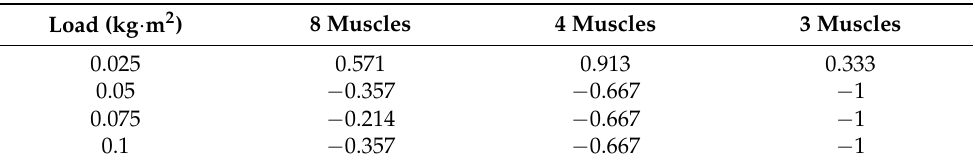
Eight muscles sequence corresponds to: soleus (sol); lateral gastrocnemius, semimembranosus, biceps femoris (bf), vastus medialis, vastus lateralis (vl), rectus femoris and glutes maximus (glut) muscles; 4 muscles: sol, bf, vl and glut; 3 muscles: sol, vl, glut.